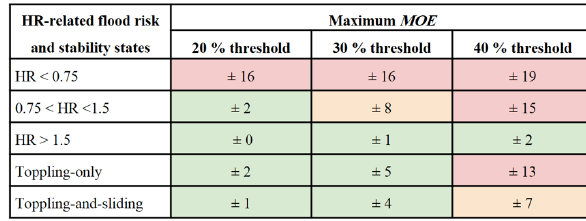
Table 6. Maximum margin of error (MOE) for the average number of pedestrian agents with different HR-related flood risk or stabil- ity states that are extracted from the recorded outputs throughout the simulations for each 20%, 30%, and 40% threshold. Different ranges of the evaluated maximum MOE are highlighted with differ- ent colour shades: green, orange, and red to indicate MOE ≤ ± 5, 6 ≤ MOE ≤ 9, and MOE ≥ 10,